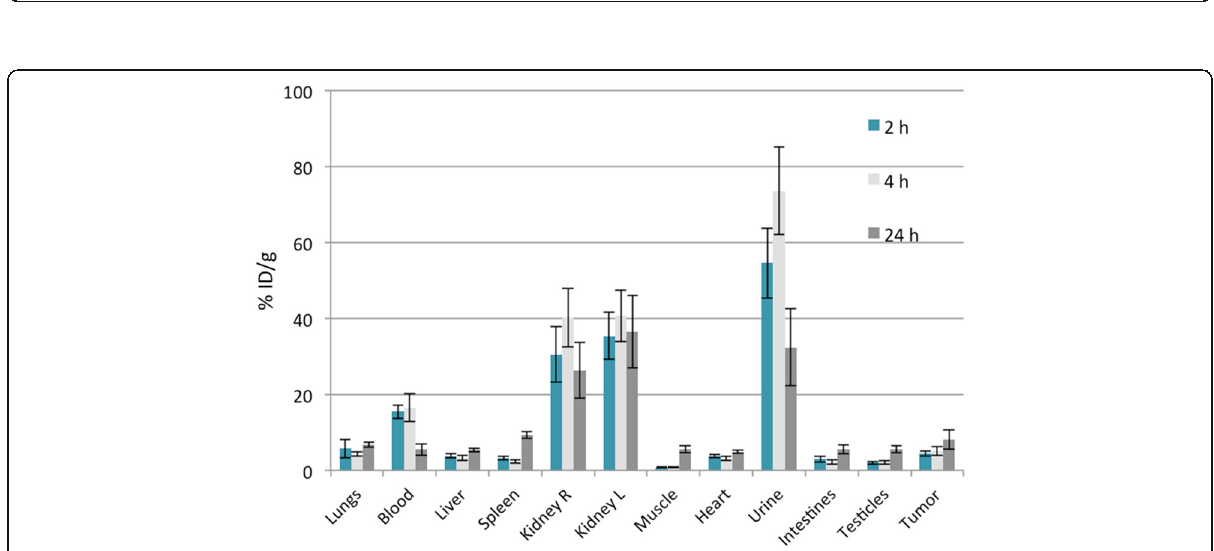
Fig. 8 a In vivo dynamic PET of [ 44 Sc]Sc-DOTA-HPMA 31c in a tumor-bearing mouse ( n = 1). Maximum intensity projections (MIPs) of different time points during 2-h acquisition. b Representative static PET images of [ 44 Sc]Sc-DOTA-HPMA 31c in tumor-bearing mice 2, 4, and 24 h p.i. (the last 30 min is imaged). Coronal and axial slices are shown with focus on tumor